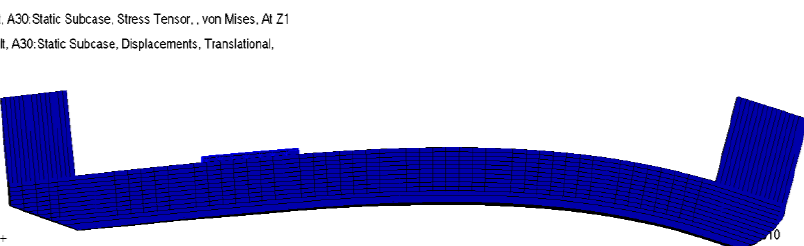
Figure 27. Schematic diagram of the deformation of the hull structure at the time of the accident.